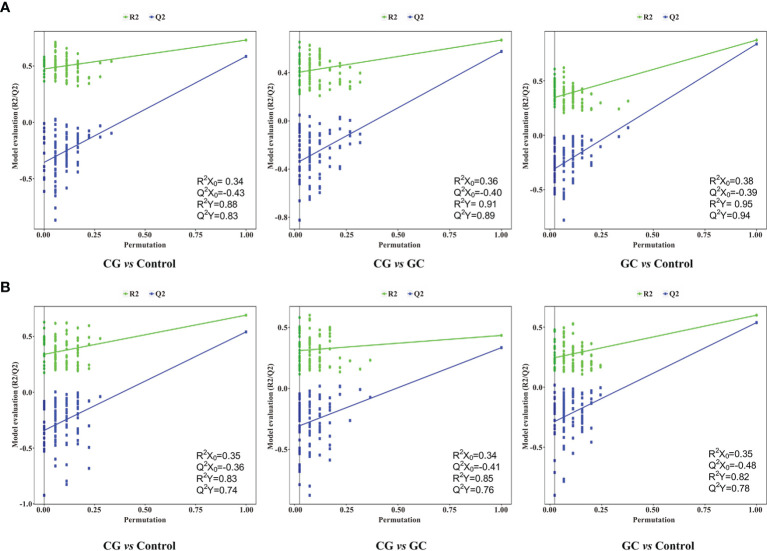
Permutation tests of the PLS-DA model for CG vs Control, CG vs GC, and GC vs Control in the (A) ESI+ and (B) ESI− ion modes. Random permutations (a total of 200) were used to evaluate whether a possibility of overfitting in the PLS-DA model. The statistical parameters R2X0, Q2X0, R2Y, and Q2Y were used for the analysis of the multivariate models.